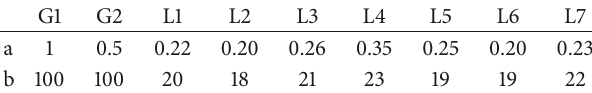
Table 2: Parameters of cost functions (10 −3 ) .